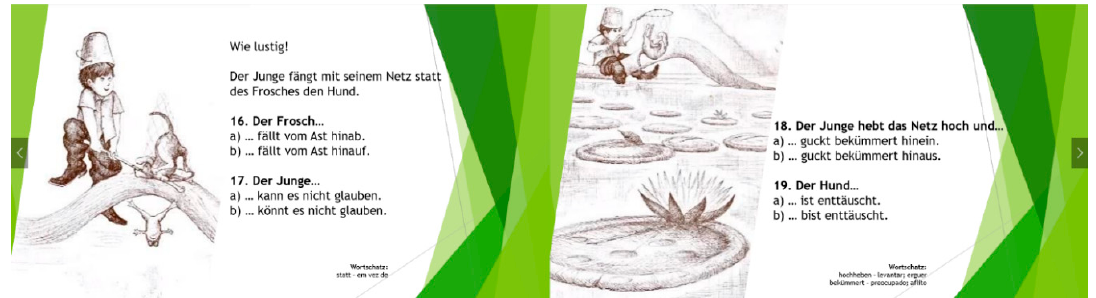
Figure A19. Pretest: Binary-choice recognition task.